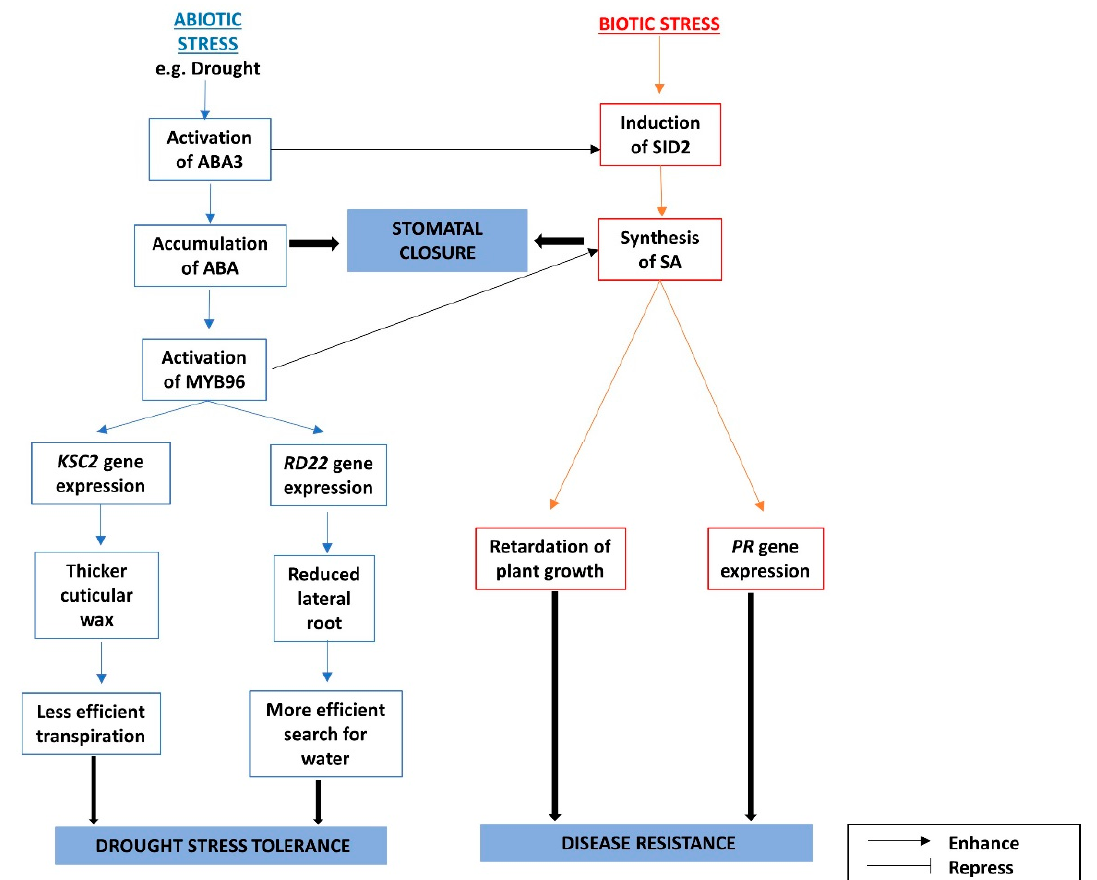
Figure 3. The interactions between abscisic acid (ABA) and salicylic acid (SA) signaling pathways under biotic and abiotic stresses are mediated through MYB96.